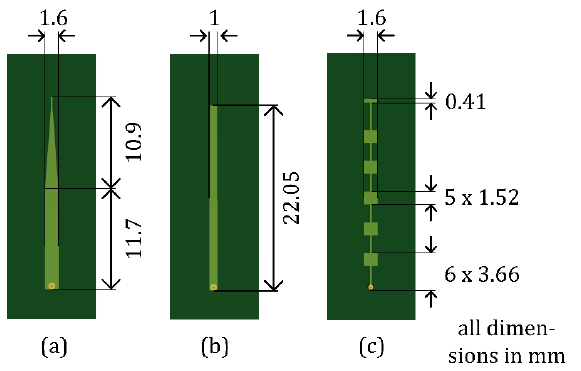
Figure 4. Simulated and tested compensation electrode geometries: ( a ) is the pentagonal compensation electrode geometry, ( b ) is the rectangular compensation electrode geometry, and ( c ) is the discrete compensation electrode geometry.